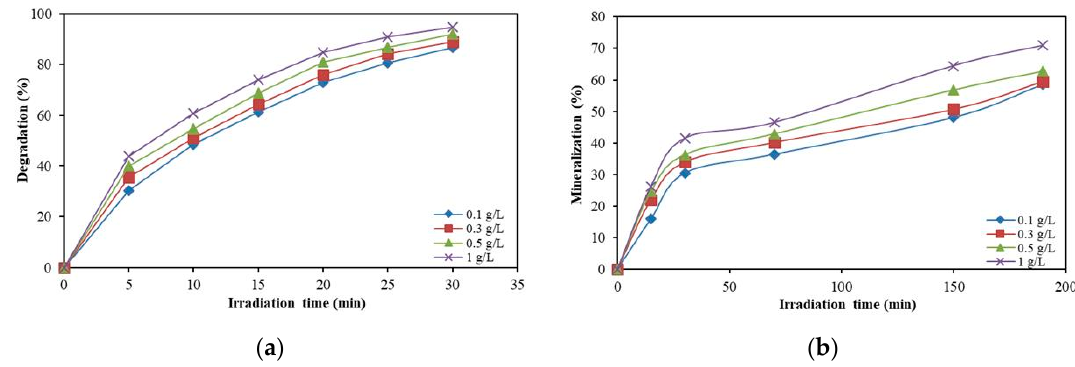
Figure 4. E ff ect of catalyst loading on degradation ( a ) and mineralization ( b ) e ffi ciency of the Figure 4. Effect of catalyst loading on degradation ( a ) and mineralization ( b ) efficiency of the target target molecule .